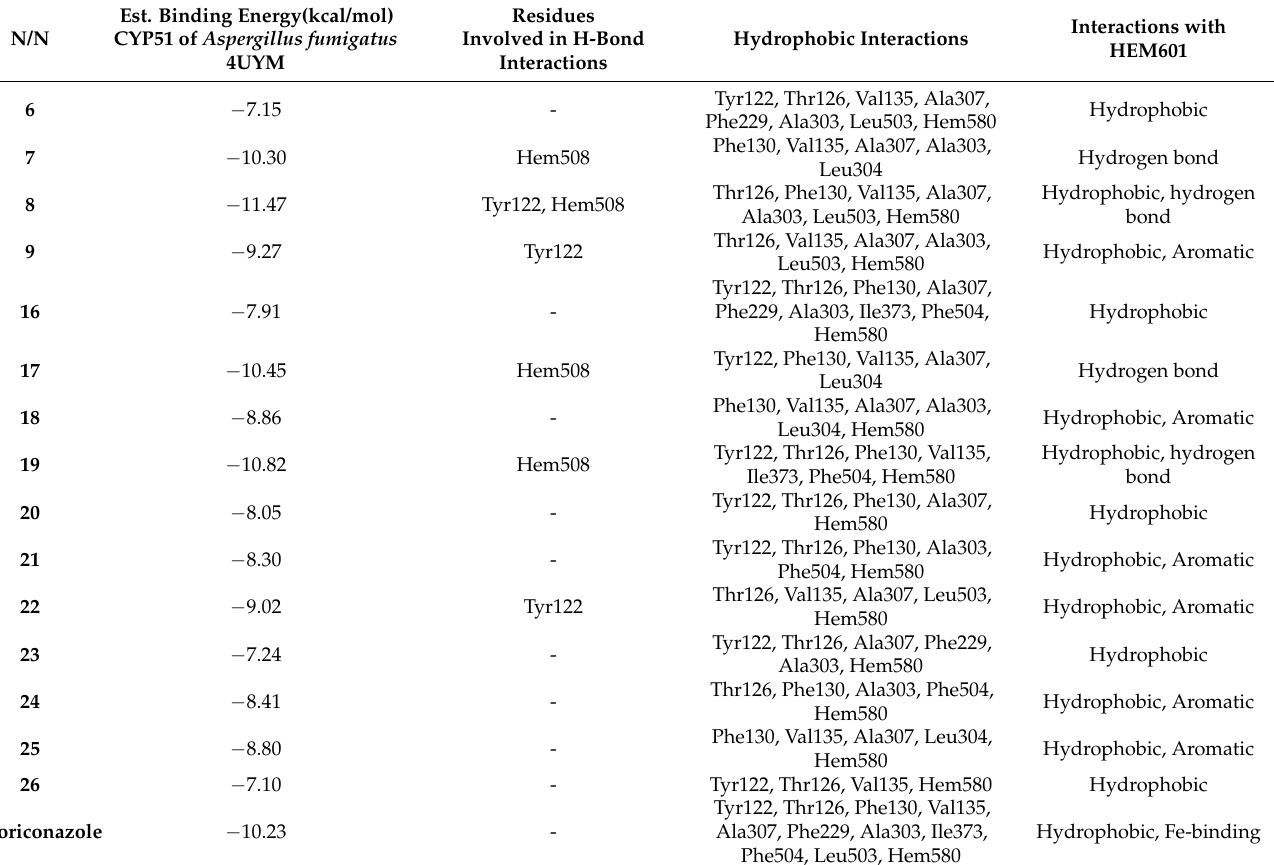
Table 3. Molecular docking free binding energy estimates to 14-alpha demethylase (CYP51B) from the fungus Aspergillus fumigatus in complex with